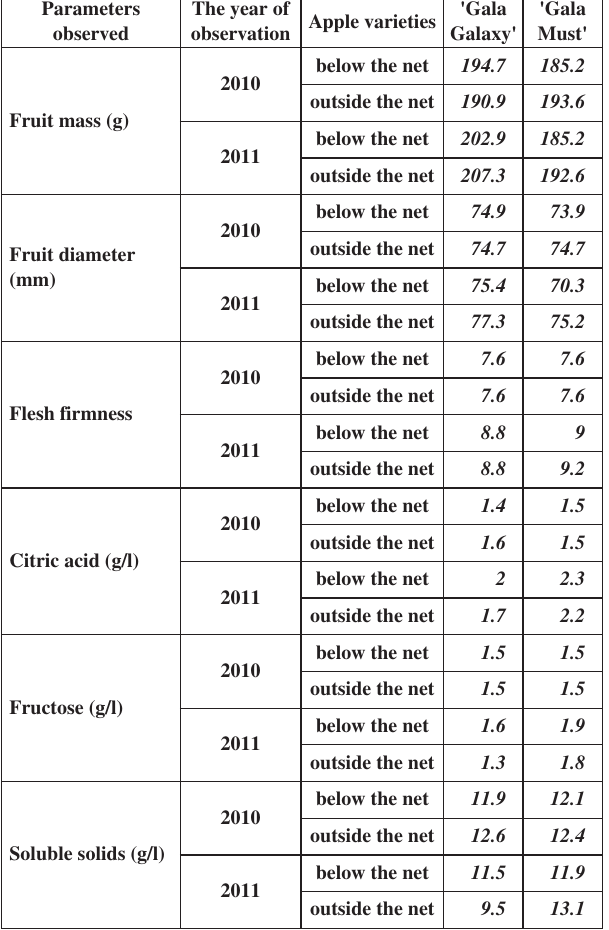
Table 1. Parameters of fruit quality under the hail net and outside of it ( Debrecen-Pallag, 2010–2011) Parameters